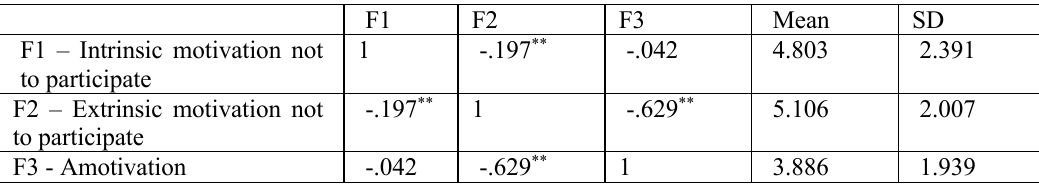
Table 1: Correlation and the basic statistics of the factors F1 F2 F3 Mean SD 1 -.197 ** -.042 4.803 2.391 -.197 ** 1 -.629 ** 5.106 2.007 -.042 -.629 ** 1 3.886